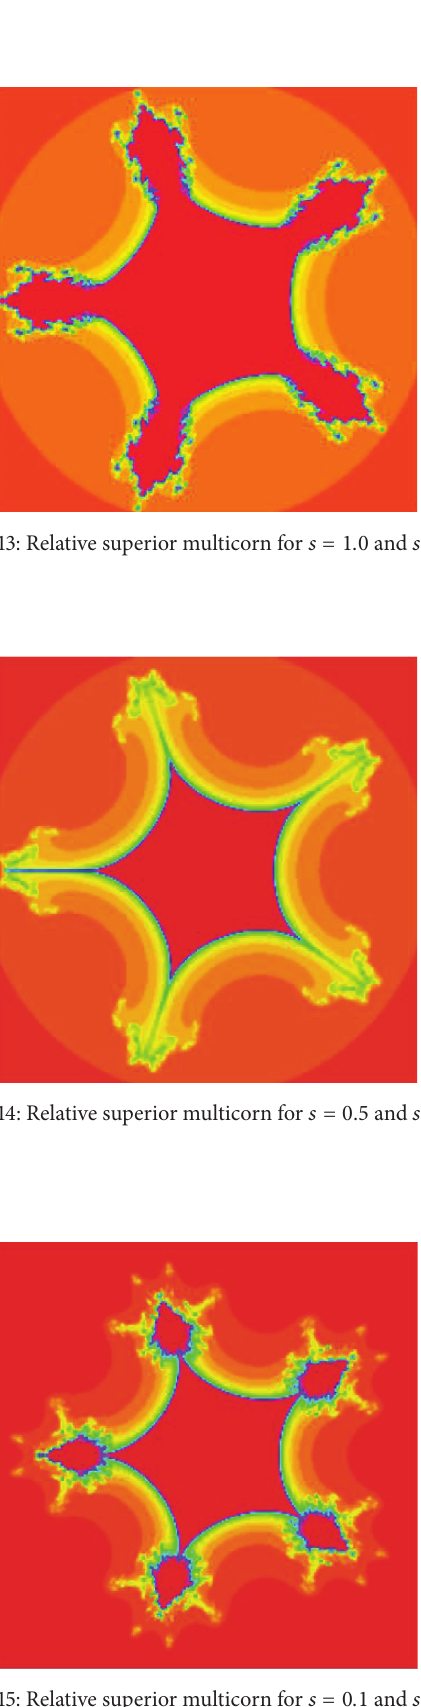
Figure 15: Relative superior multicorn for 𝑠 = 0.1 and 𝑠 󸀠 = 0.8